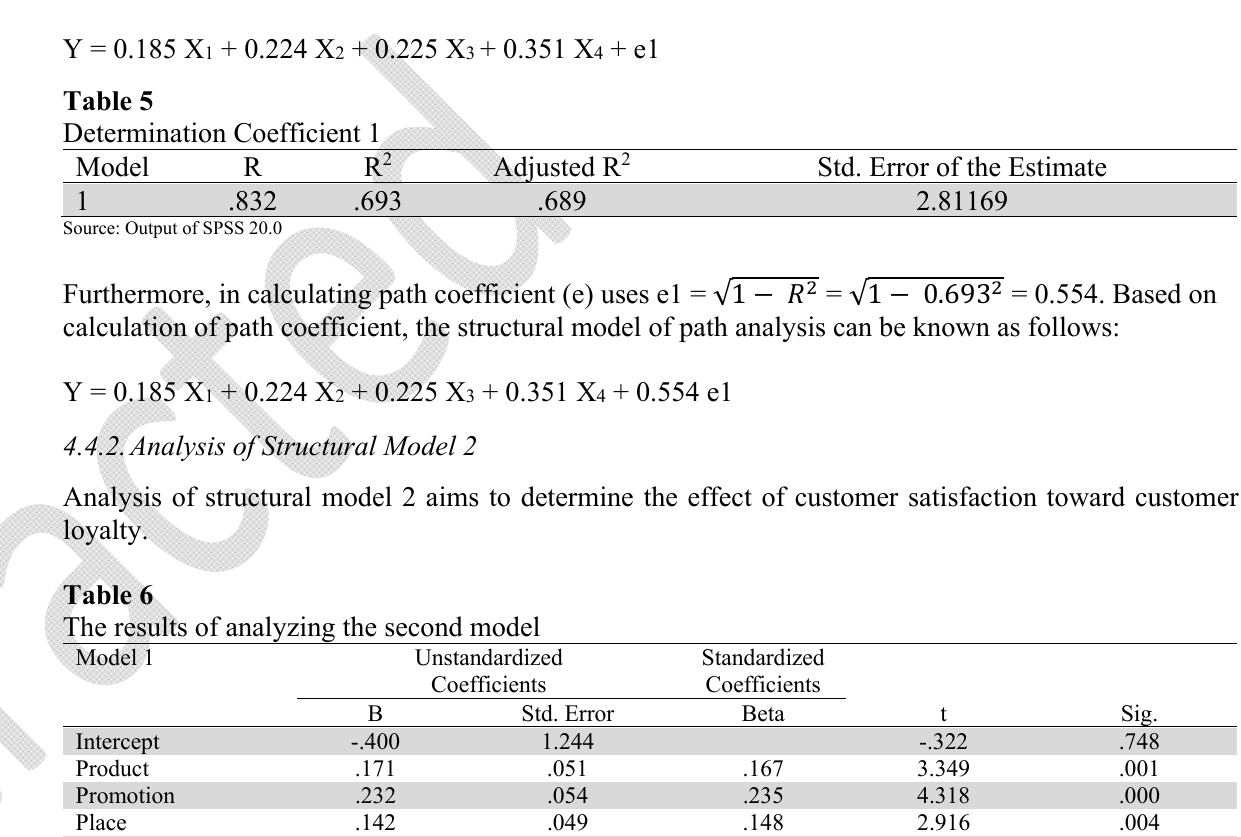
Standardized Coefficients